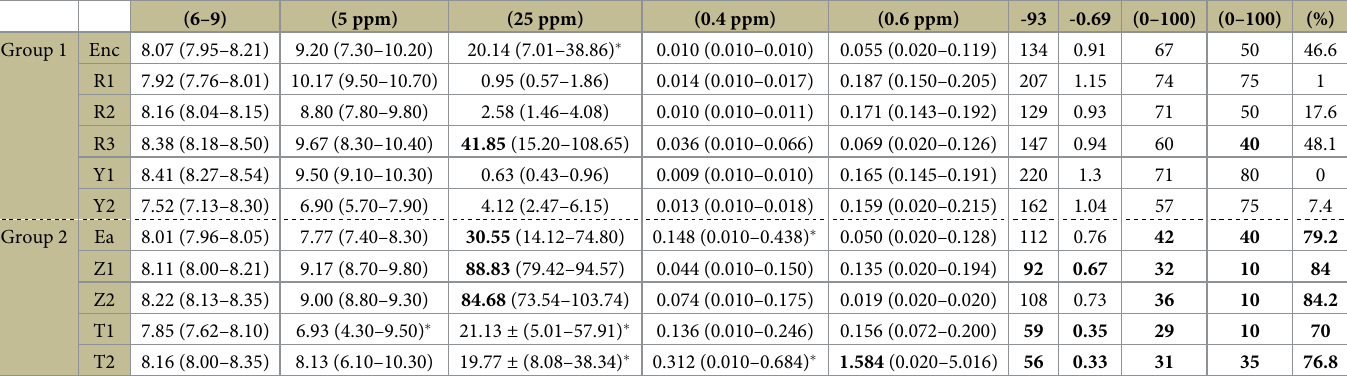
Table 1. Environmental variables. Values of the physicochemical variables and the biotic indices -IBMWP (Iberian Biological Monitoring Working Party) and IMMi-T (Iberian Mediterranean Multimetric Index)- used to assess the good ecological status of streams according to the Spanish legislation (RD 817/2015), based on the European Water Framework Directive (WFD). The limits established by the Spanish legislation to consider a water body at good ecological status or higher for “Calcareous Mediter- ranean mountain rivers” are shown in parentheses. For chemical variables, mean values and ranges (i.e. minimum and maximum) are shown. Values exceeding the thresh- old for the good ecological status according to the RD 817/2015 are highlighted in bold. Asterisk indicate that although the mean values were below the threshold, the threshold was exceeded at least once during the study period. The lowest detectable values for phosphate and ammonia were 0.010 and 0.020, respectively. IHF (River Hab- itat Index) and QBR (Riparian Forest Quality Index) values, which are not considered by RD 817/2015 to determine the good ecological status of a water body, are shown at the right part along with the percentage of area occupied by agricultural land upstream the study site (AGR). The ranges for IHF and QBR are shown in parentheses, with higher scores associated to better habitat conservation. The lowest values of IHF ( < 50) and QBR ( < 50) and the highest values of AGR ( � 70) are highlighted in